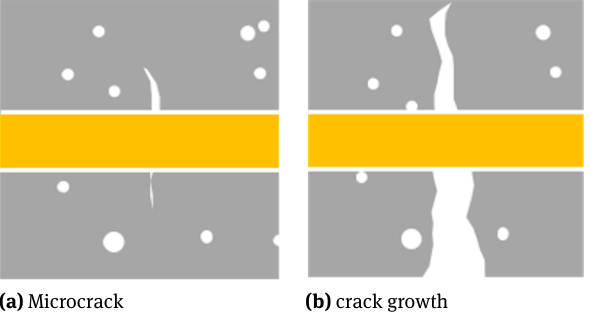
Figure 11: Crack bridging of PVA fibers.